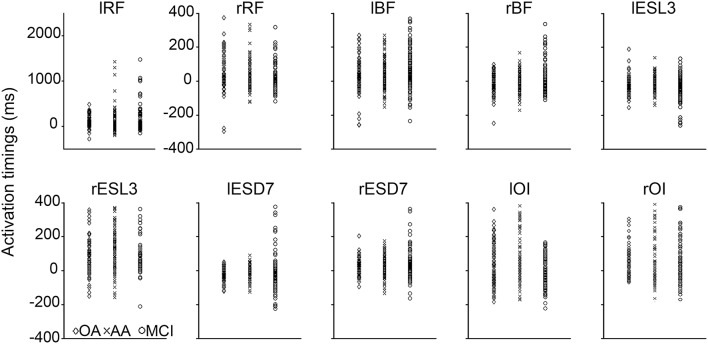
Scatter plot of the activation timings raw data for all the trials of every participant in the three experimental groups. These activation timings (ms) were computed for each tested muscle with reference to the anterior deltoid activation. The timing of muscles involving in the APA had negative values and positive values refer to post-deltoid contractions. In every graph, the activation timings of the young adults (YA) were reported in the left column (diamond markers), the older adults (OA) in the middle column (cross markers), and the mild cognitive impairment group (MCI) in the right column (circle markers).